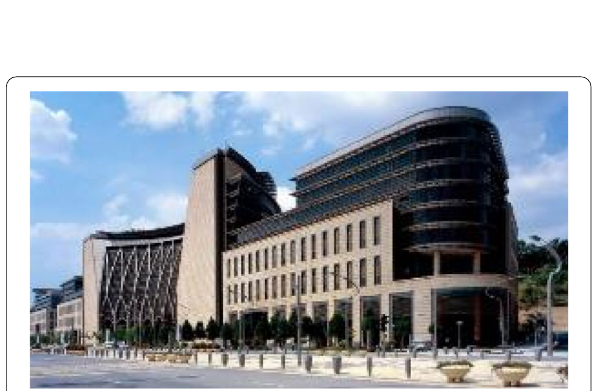
Fig. 8 Exterior of the Ministry of Finance (GDP web, 2020)